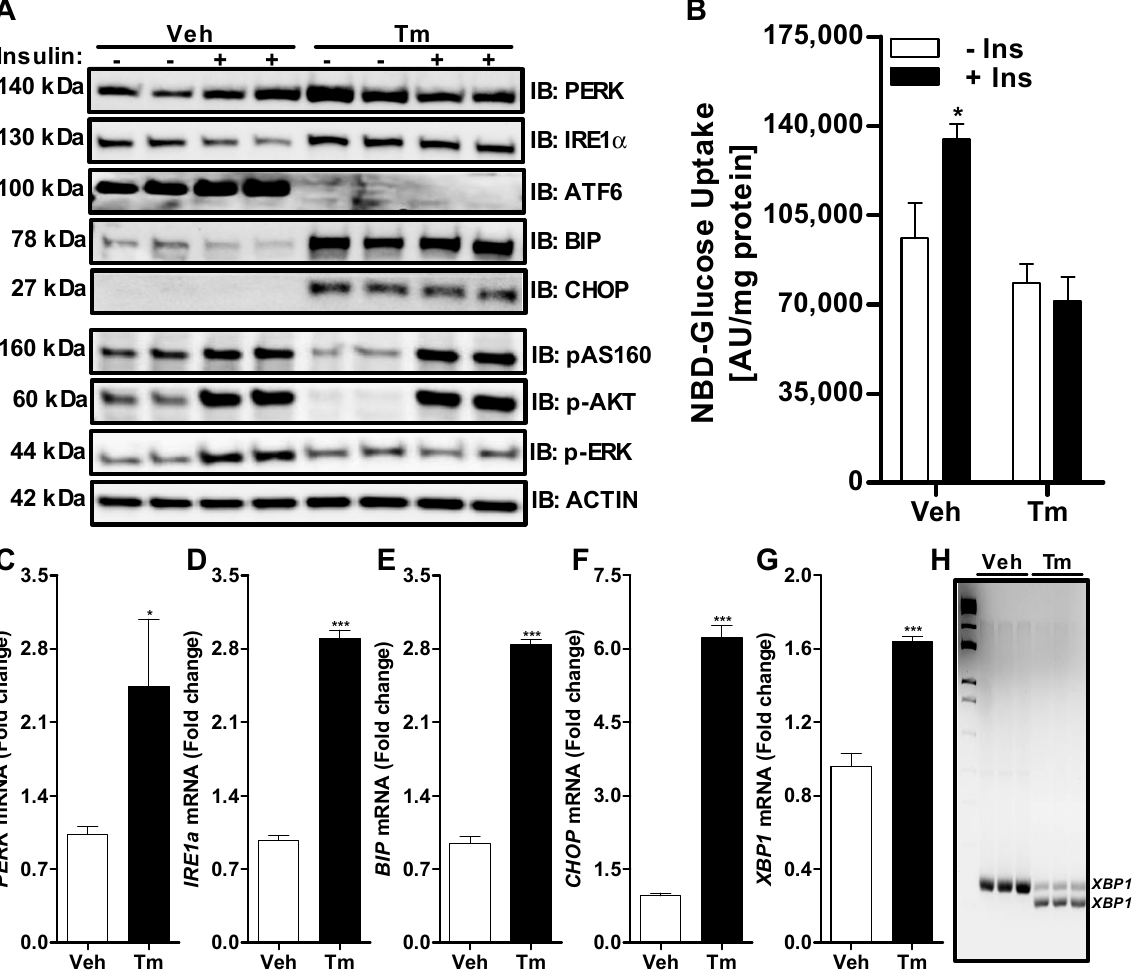
Figure 1. Tunicamycin induced ER stress alters insulin signaling in Huh-7 cells. Huh-7 cells were treated with either DMSO (Veh) or 10 mg/mL of tunicamycin (Tm) for 6 h prior to a 15 min acute challenge with 250 nM of bovine insulin. Cells were used to measure the expression of ER stress and downstream insulin signaling pathway proteins by Western blotting (Panel A ). In a separate experiment, cells were used to determine the uptake of 2-NBD glucose for 1 h in triplicate after the insulin challenge (Panel B ). Cells were also used for the extraction of total RNA to measure the expression of various ER stress genes by qRT-PCR (Panels C – G ). Unspliced (u) and spliced (s) forms of XBP1 mRNA were measured by RT-PCR (Panel H ). Values were plotted as mean ± SD. p values were calculated using Student’s t test. *, p < 0.05; ***, p < 0.001.